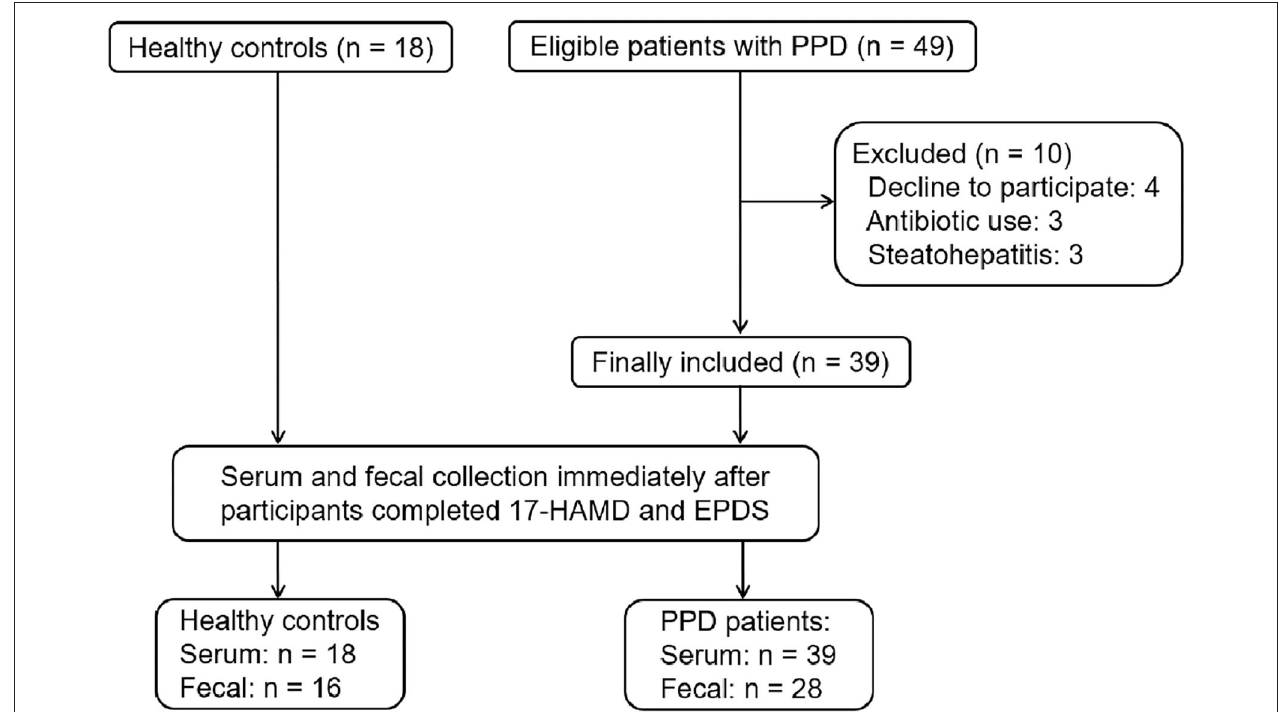
FIGURE 1 | The recruitment of participants and the process of sample collection.